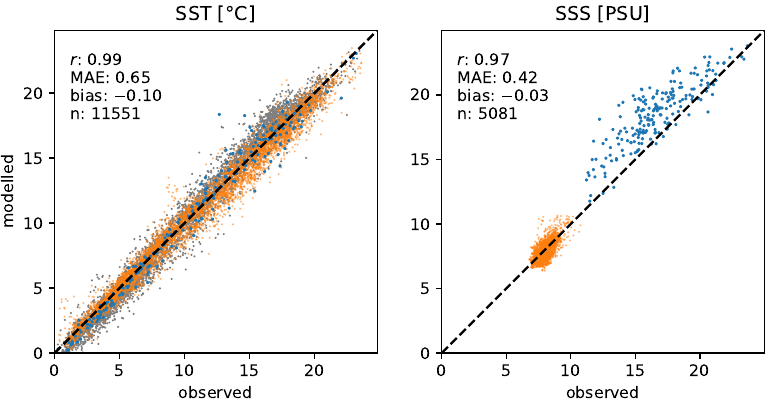
Figure 3. Validation of SST and SSS products of the GETM realization with observations at stations Boknis Eck (blue), Kühlunsborn (gray), and Arkona Basin (orange). Note that at Kühlungsborn, only SST is measured. r : Pearson correlation coefficient. MAE: mean absolute error. n: number of